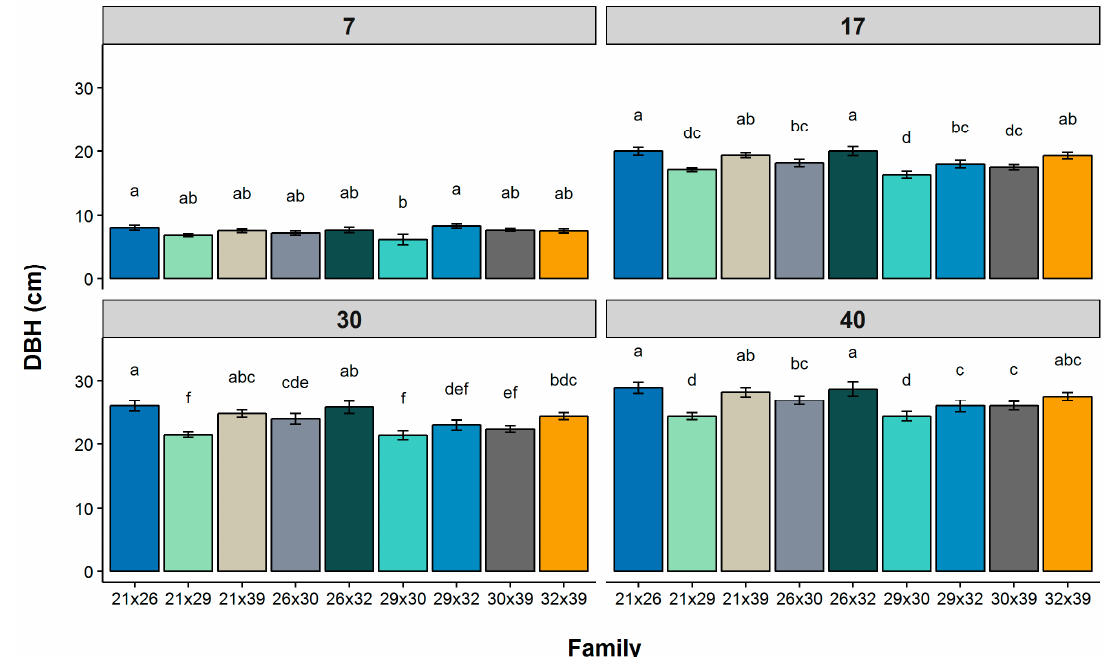
Figure 3. Family mean DBH values for all families at ages 7, 17, 30 and 40. Lines on each bar represent the standard error of the mean. Families with the same letter within a time period are not significantly different from each other as indicated by Tukey HSD post-hoc test ( α = 0.05).